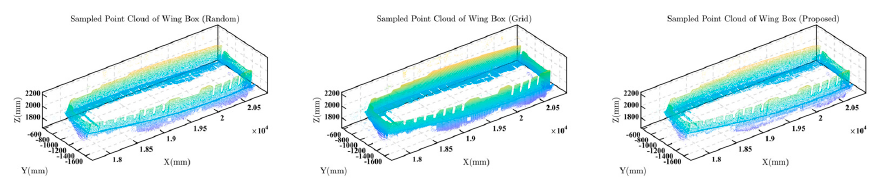
Figure 9. The point cloud resampling results of the wing box.